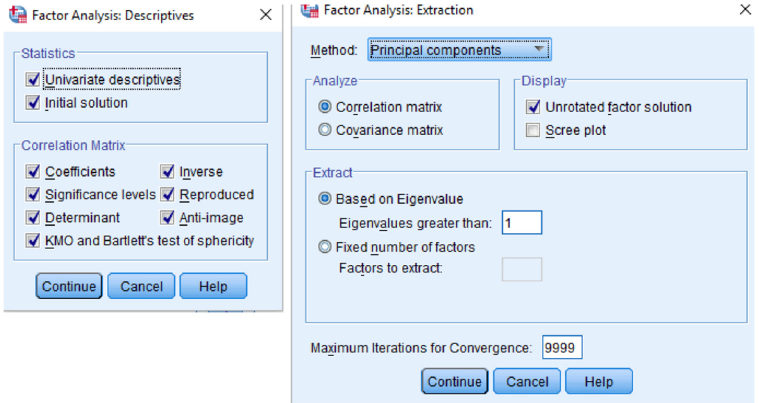
Figure 3. Dialog boxes